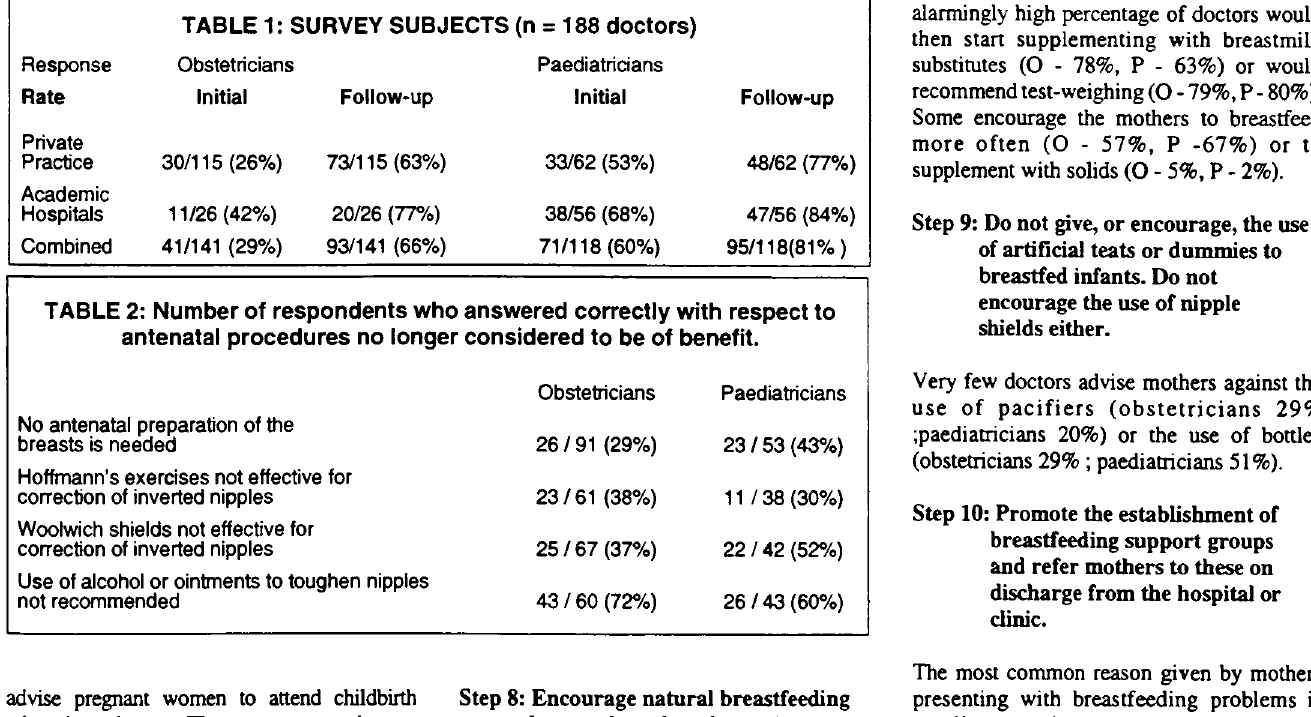
TABLE 1: SURVEY SUBJECTS (n = 188 doctors)